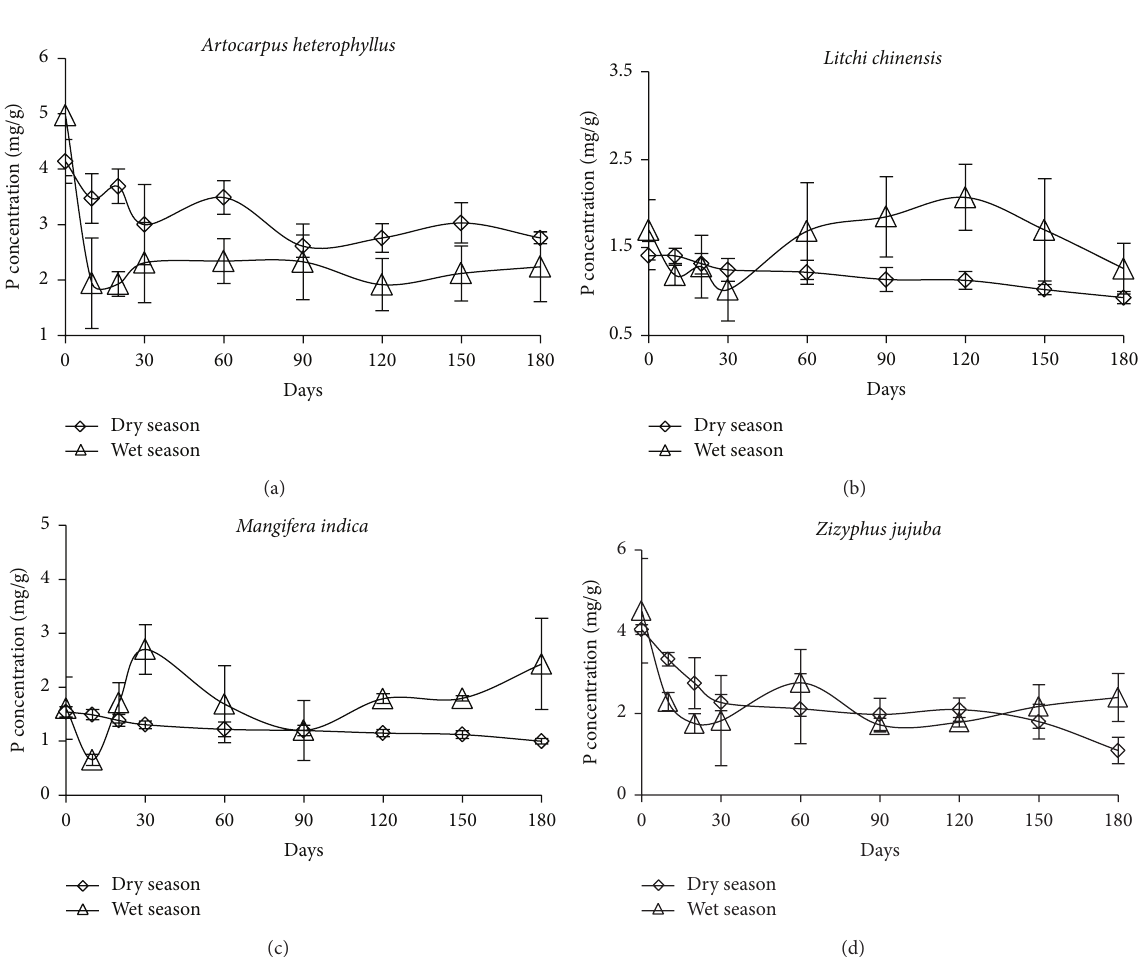
Figure 4: P concentration (mg/g) of leaf litter of four tree species used in agroforestry during the dry and wet seasons over 180-day periods due to microbial